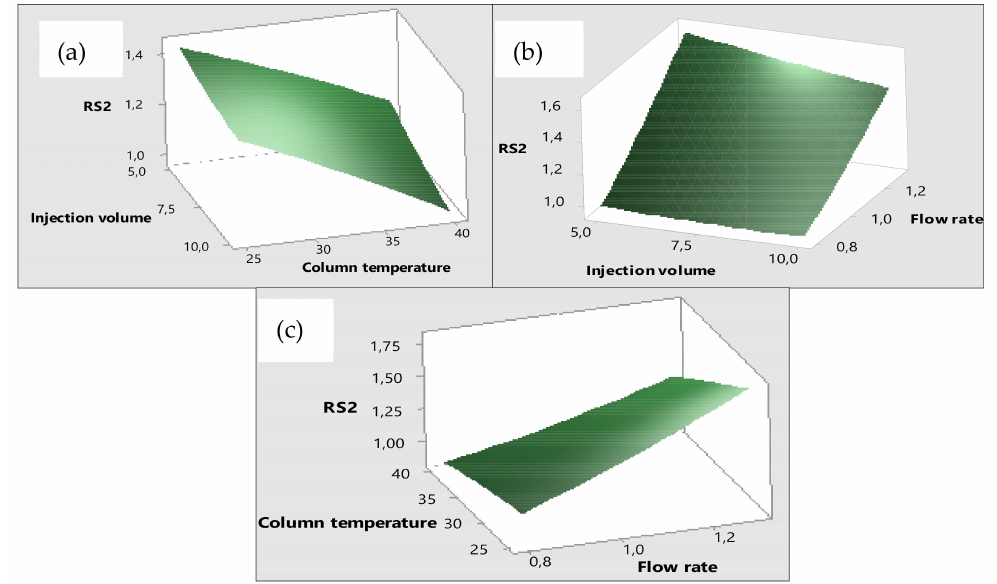
Figure 4. ( a ) The surface plot of the effects of injection volume and column temperature on RS2 while keeping flow rate constant; ( b ) effects of injection volume and flow rate on RS2 while keeping column temperature constant; and ( c ) effects of column temperature and flow rate on RS2 while keeping injection volume constant.